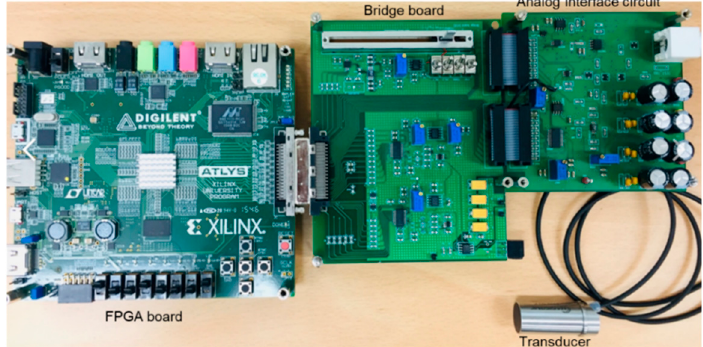
Figure 13. Implemented image-free ultrasound blood-flow-monitoring circuit system.